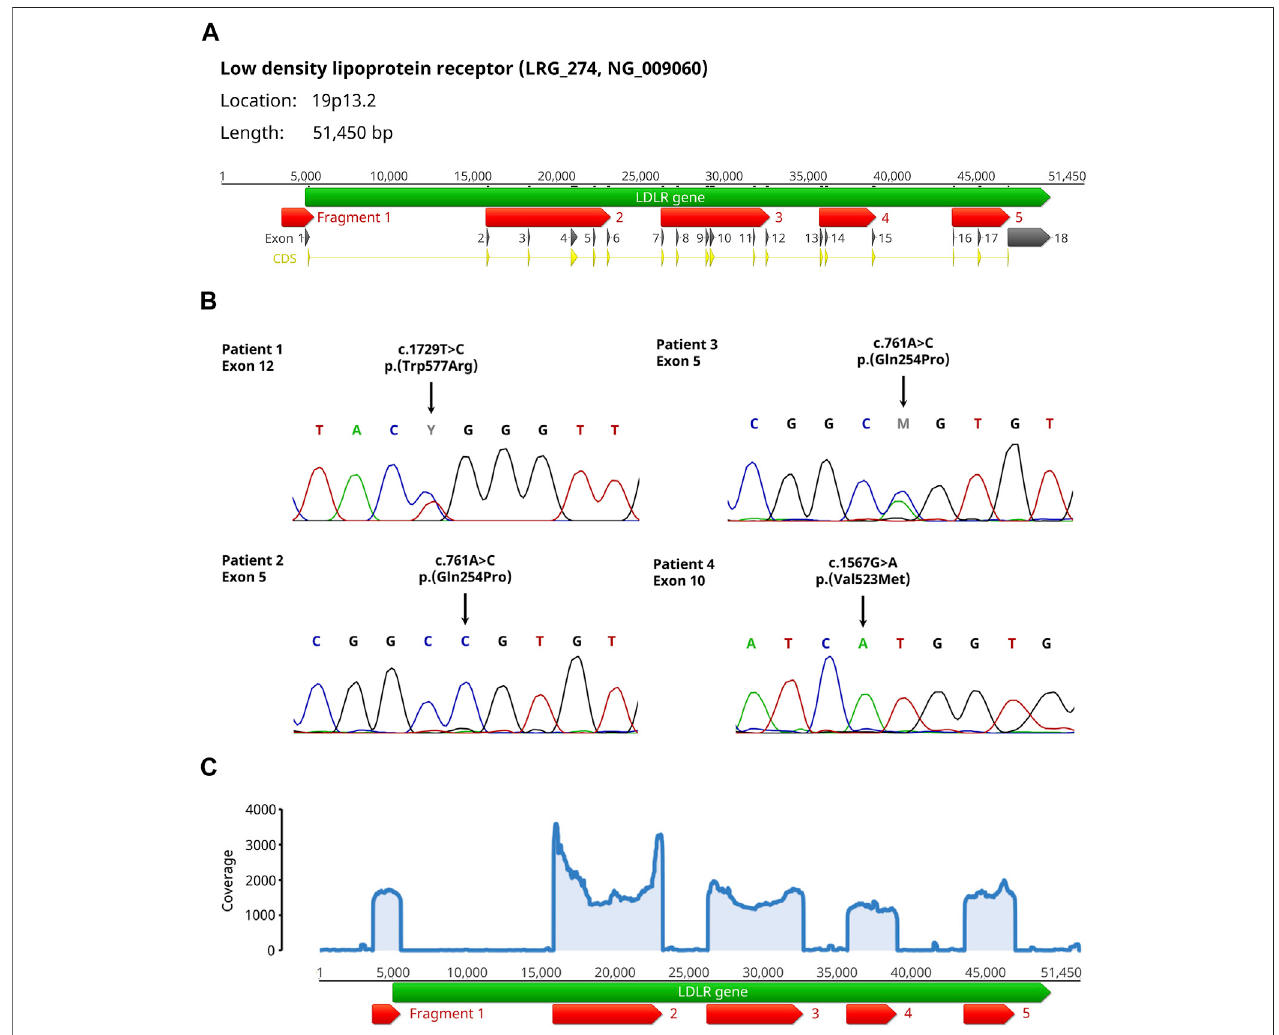
FIGURE1| SetupandresultsofthevalidationexperimentsfortheNanoporesequencingwork fl owofthe LDLR gene. (A) The LDLR gene(greenarrow)isampli fi ed in 5 fragments (red arrows) covering the promoter region and the coding sequences (yellow arrows) of all 18 exons (dark grey arrows). Please note, that fragment 5 only covers the starting sequence of exon 18 because the remaining part contains only untranslated sequences. (B) Sanger sequencing results from the 4 patients with homo- or heterozygous FH showing the pathogenic variants within Exons 5, 10 and 12 including the change on DNA and protein level. (C) Coverage plot of the individual fragments showing equal distribution of coverage among all fragments exemplary for patient 4. For all 4 patients, the mean coverage was above 900 with a maximum mean coverage of 2,347.